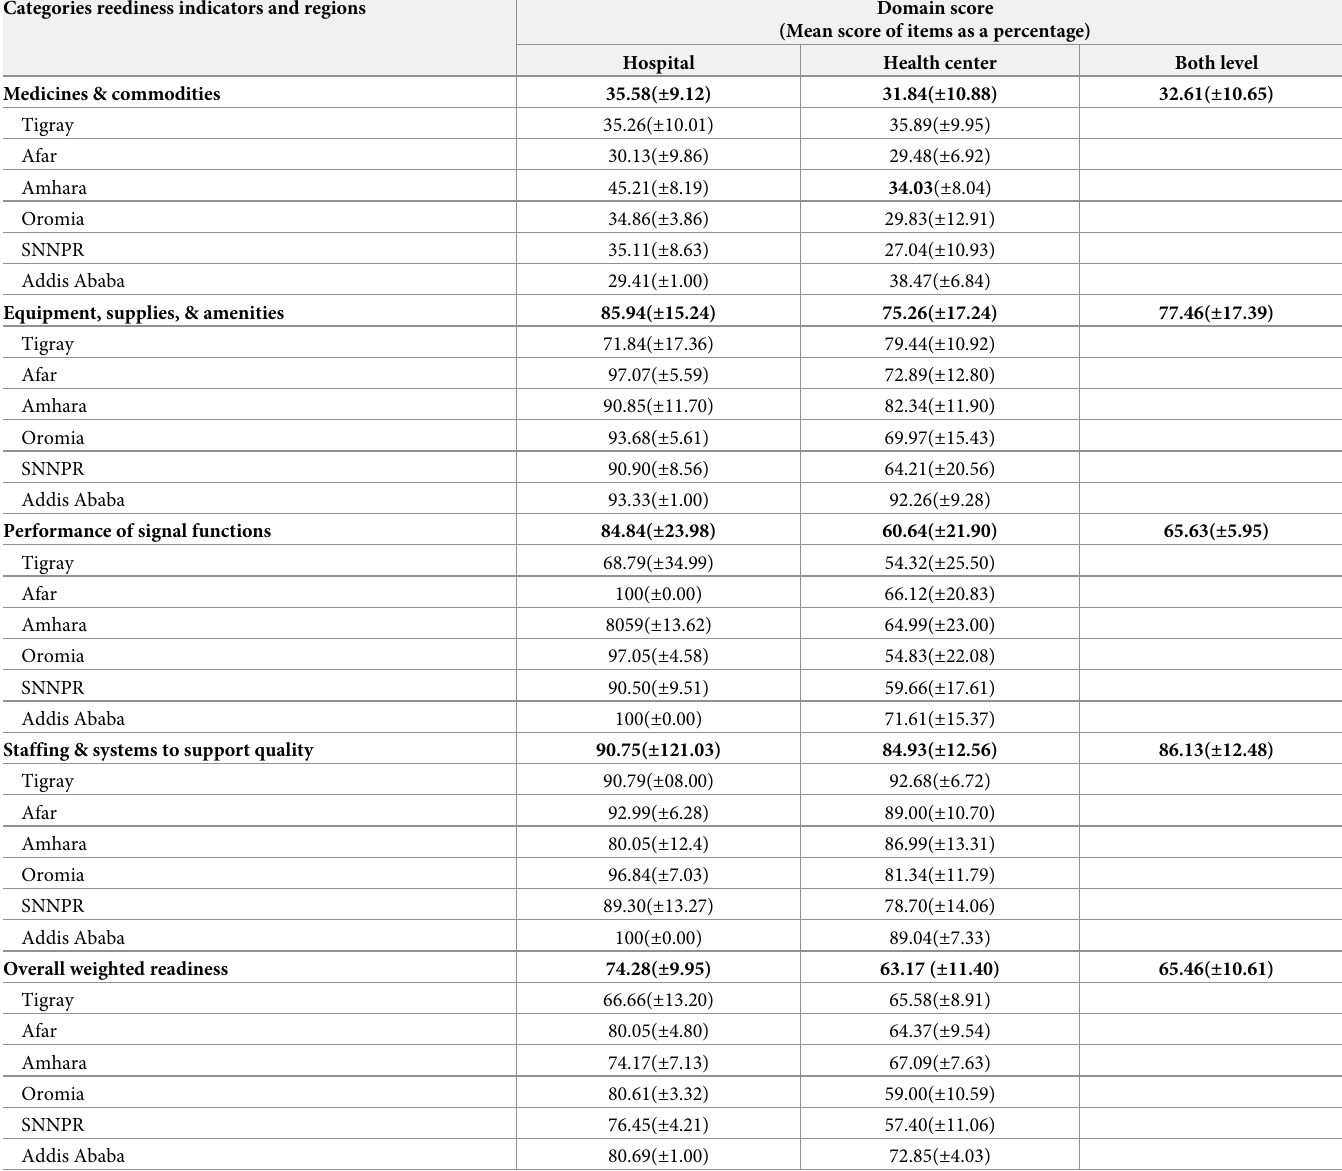
Table 3. WHO standards childbirth readiness index by domains of indicators and regions. Categories reediness indicators and